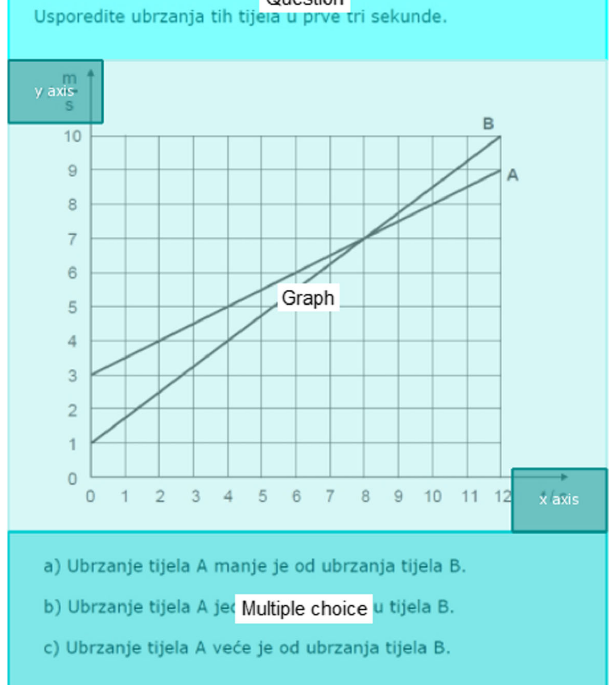
FIG. 1. Example of definition of AOIs for one test